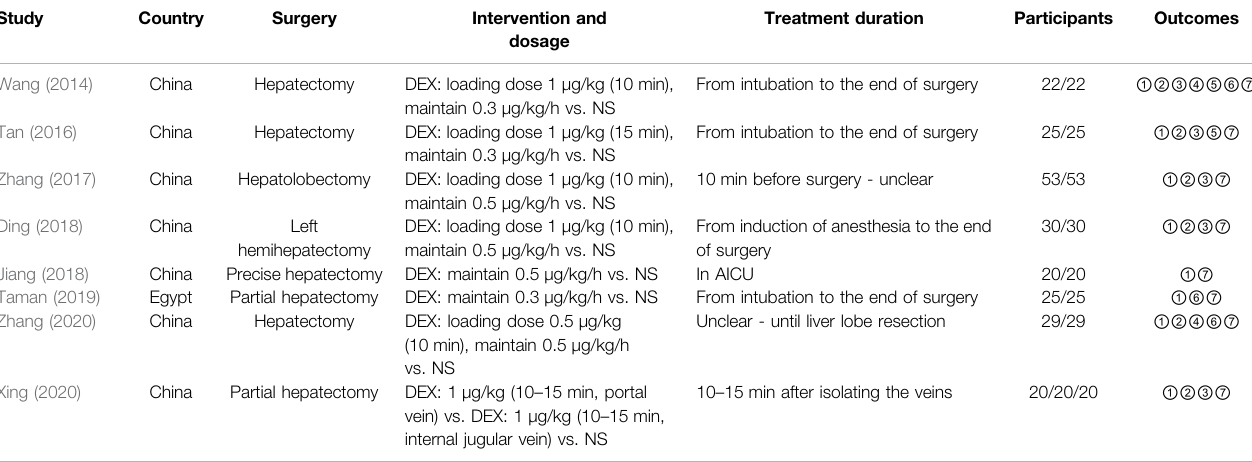
TABLE 1 | Characteristics of the included RCTs.